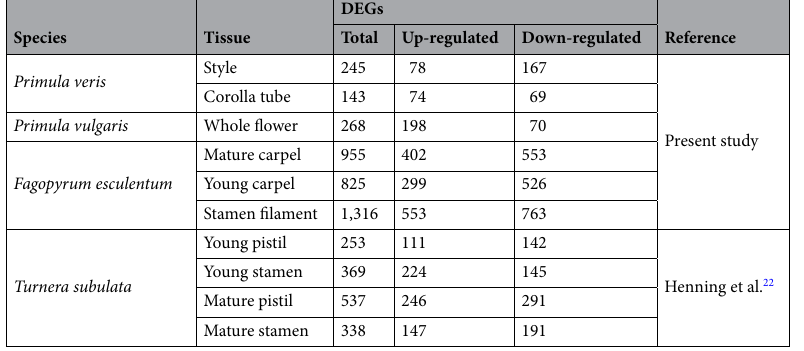
Table 1. Summary of differentially expressed genes (DEGs) in distylous species.